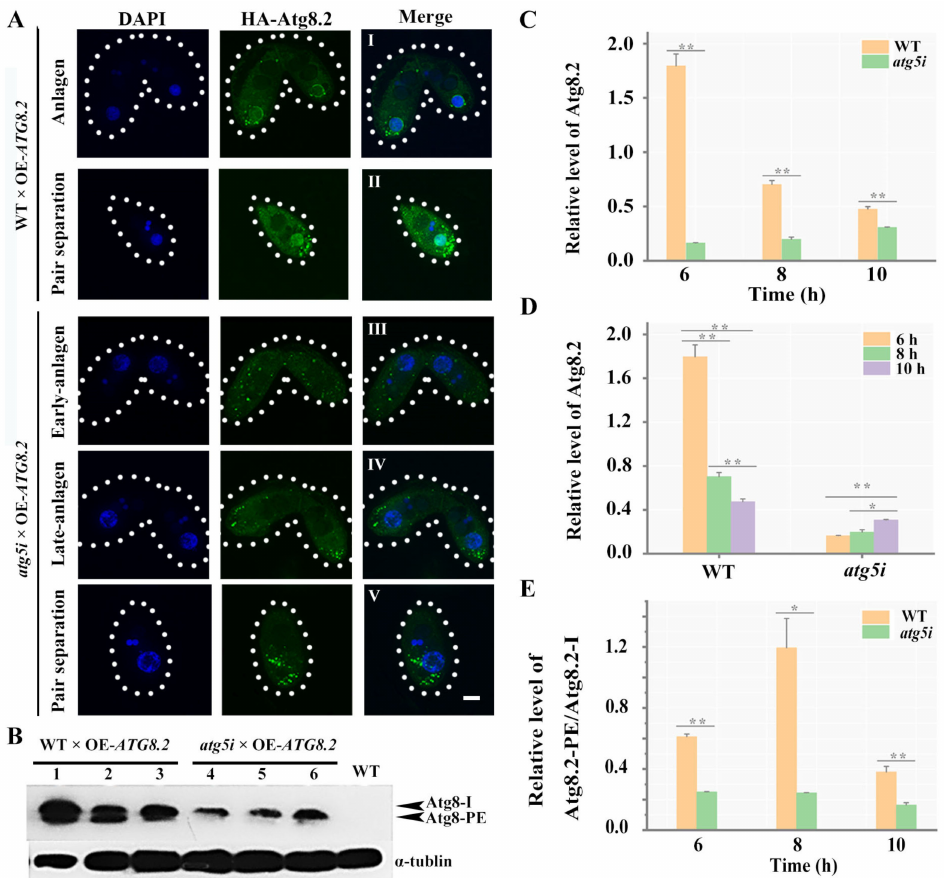
Figure 8. RNA interference of ATG5 decreased the expression and lipidation of Atg8.2 and hindered the localization of Atg8.2 on the paMAC. ( A ): WT and atg5i mutant paired cells during sexual reproduction were used to analyze the subcellular localization of Atg8.2. I, WT mating cells at the anlagen stage; II and V, WT cell and atg5i mutant cell at the pair separation stage; III, atg5i mating mutant cells at the early-anlagen stage.; IV, atg5i mating mutant cells at the late-anlagen stage. Fluorescent images were taken with a DeltaVision deconvolution microscope. Dashed circle represents the cell outline of Tetrahymena . Scale, 10 µ m; ( B ): The expression of Atg8.2 was detected by Western blot in WT and atg5i mutant paired cells. Protein samples were prepared at 6 h (lanes 1 and 4), 8 h (lanes 2 and 5), and 10 h (lanes 3 and 6) after mixing different mating types of cells; ( C – E ): Gray intensity analysis of the Western blot results was performed with Image J software. The unpaired sample t test was used in C and E , and a paired sample t test was used in ( D ). * p < 0.05 and ** p <